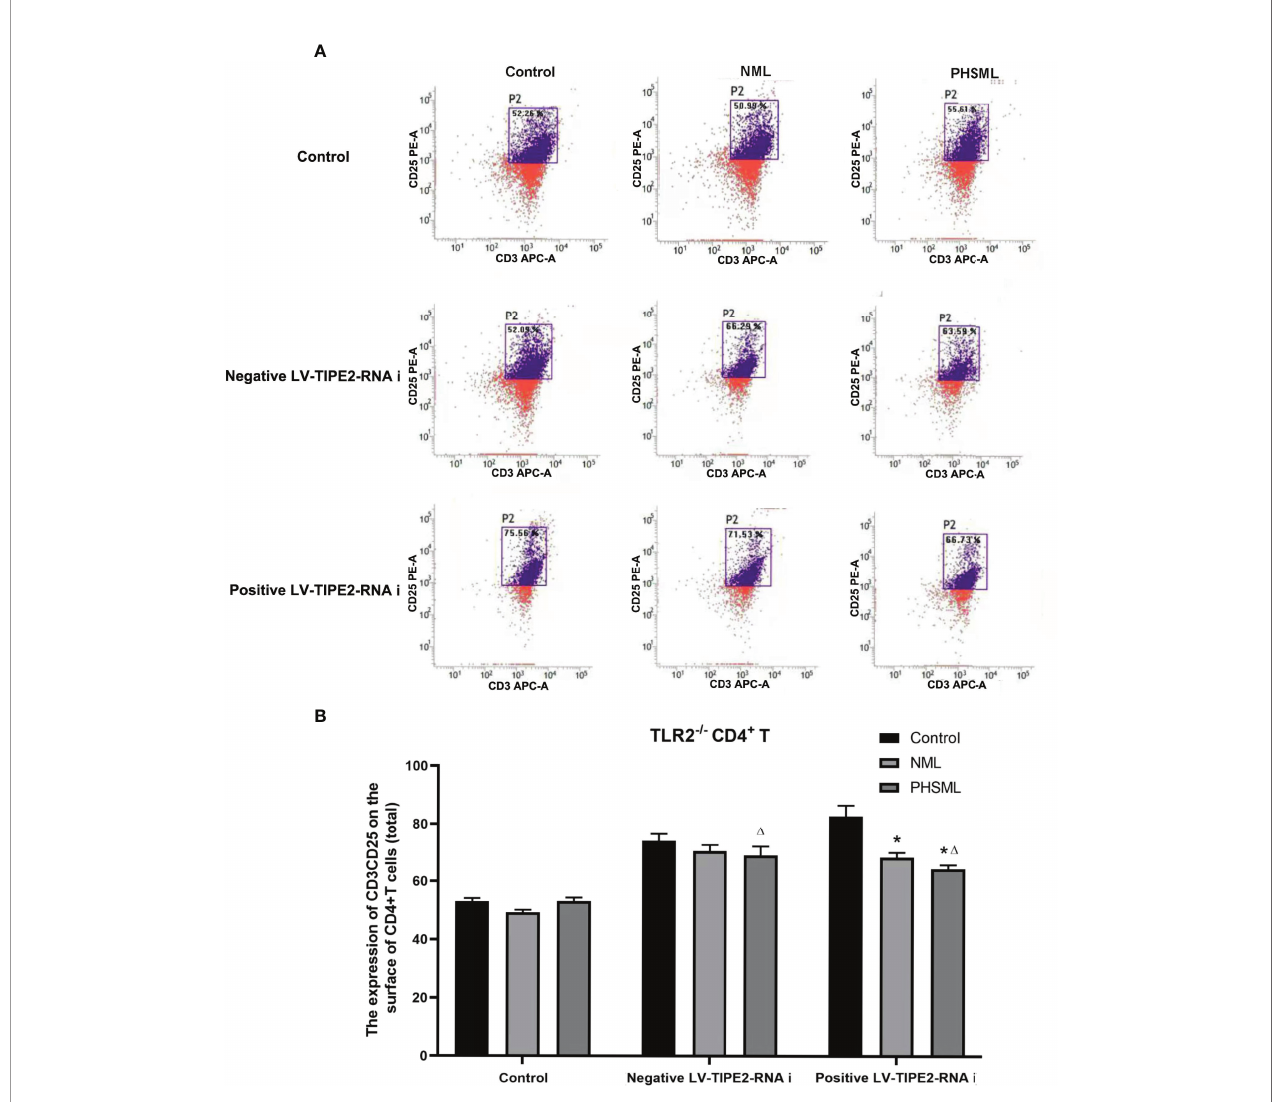
FIGURE 5 | The expression of CD25 on TLR2 -/- CD4 + T lymphocytes infected with TIPE2 shRNA following by the stimulation with PHSML detected by fl ow cytometry. (A) Representative images. (B) The percentage of CD4 + T cells expressing CD25 is expressed as the mean ± SE and is shown in a bar graph. Data are derived from three independent experiments. *P < 0.05 vs control treated control group, D P < 0.05 vs PHSML treated control